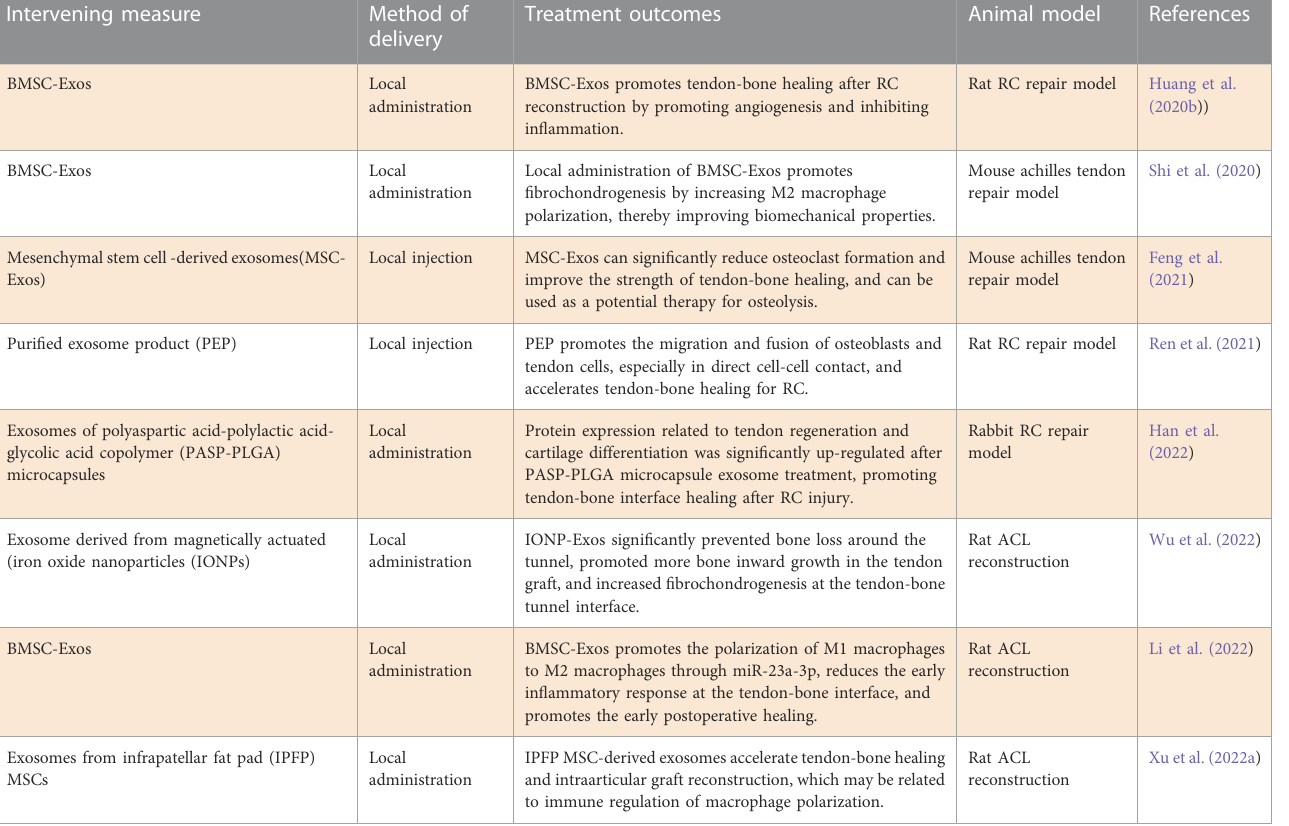
TABLE 5 Preclinical studies of exosomes used to promote tendon-bone healing.